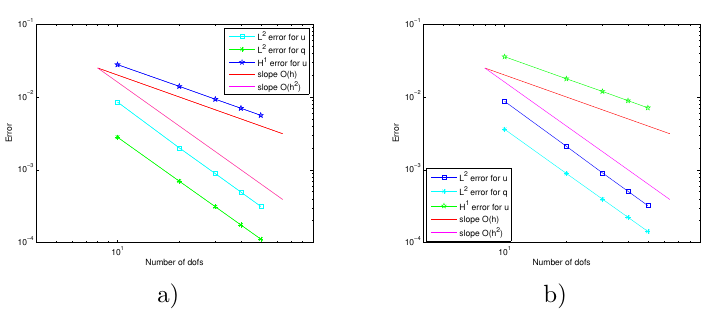
Figure 1. The convergence rates for u and q : a) at t = 0 . 4, b) t = 0 . 6